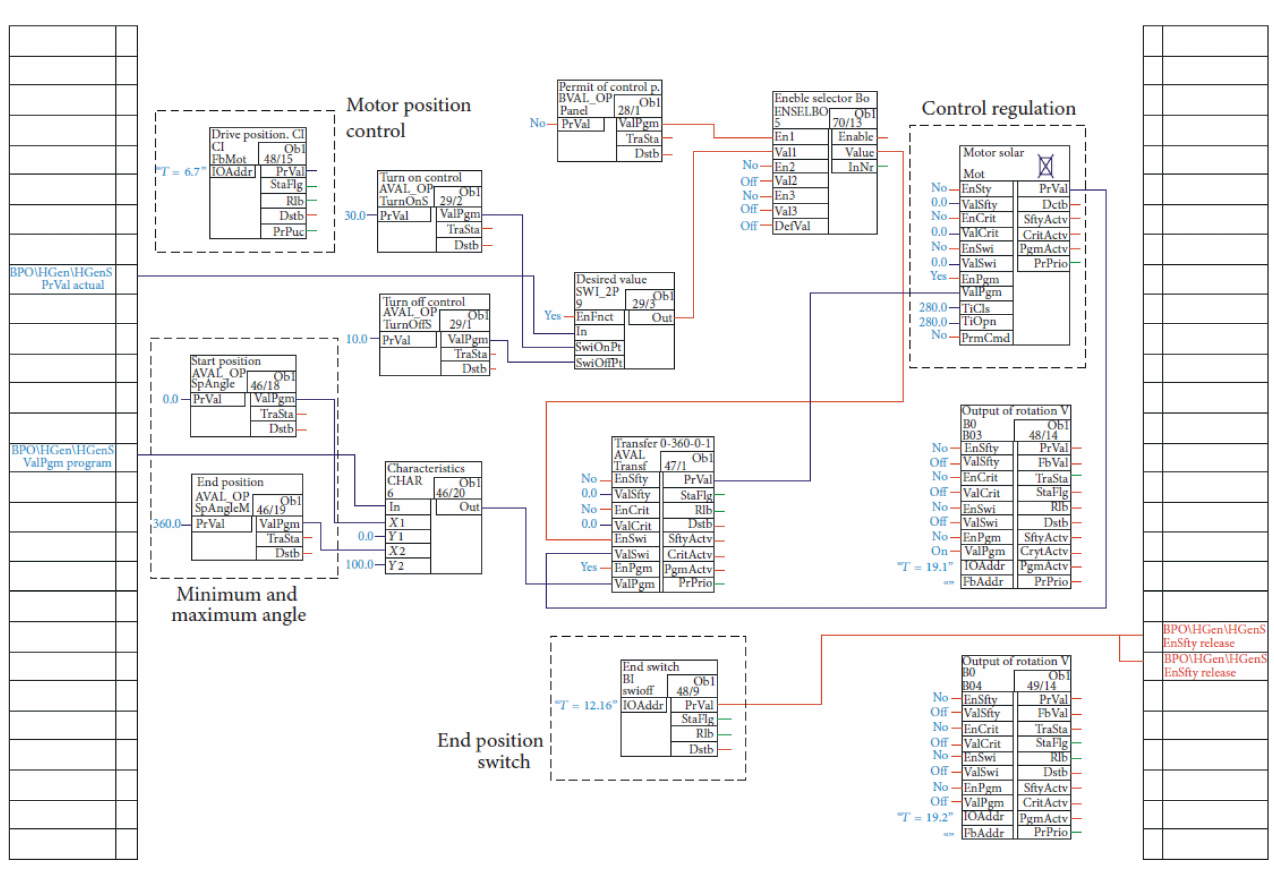
Figure 4. Block diagram of the structure rotation control system.